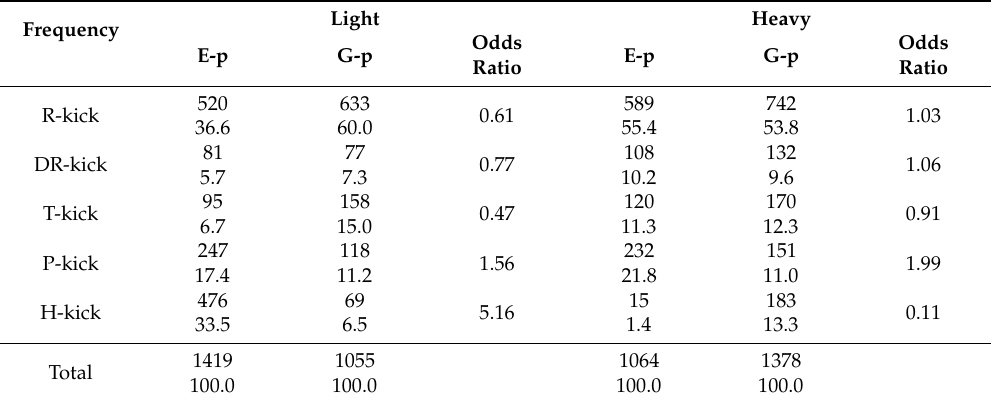
Table 6. Observed frequencies (proportions) and odd ratios for skill by protector by weight contingency table.